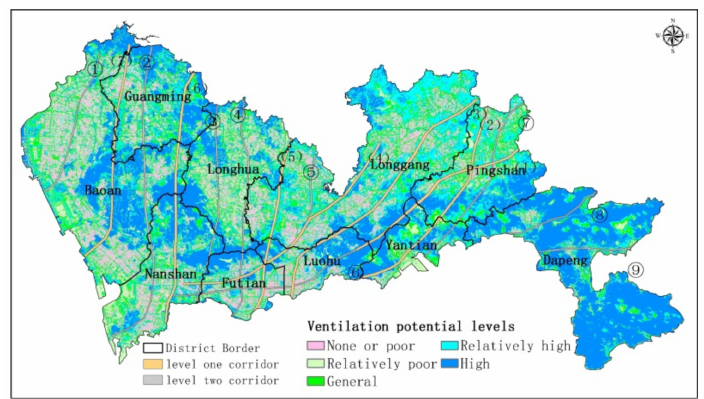
Figure 17. Recommended ventilation plan for